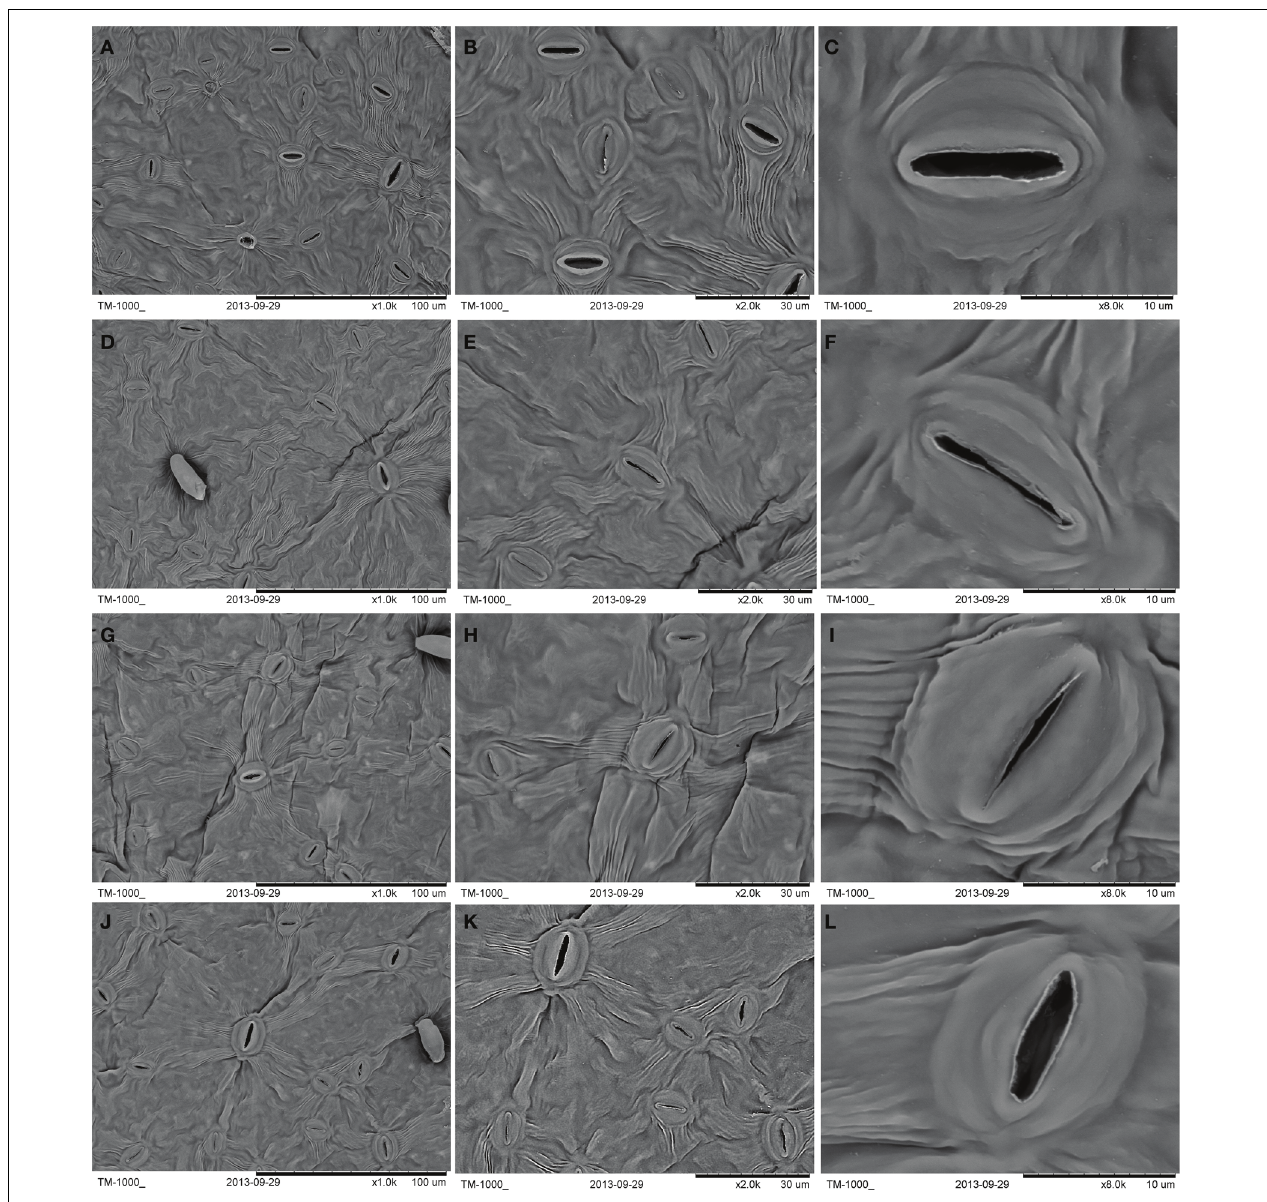
FIGURE 6 | Light intensity and stomatal traits in C. acuminata leaves under (A–C) 100% irradiance, (D–F) 25% irradiance, (G–I) 50%irradiance, and (J–L) 75% irradiance. 100% level = 1500 ± 30 µ mol m − 2 s − 1